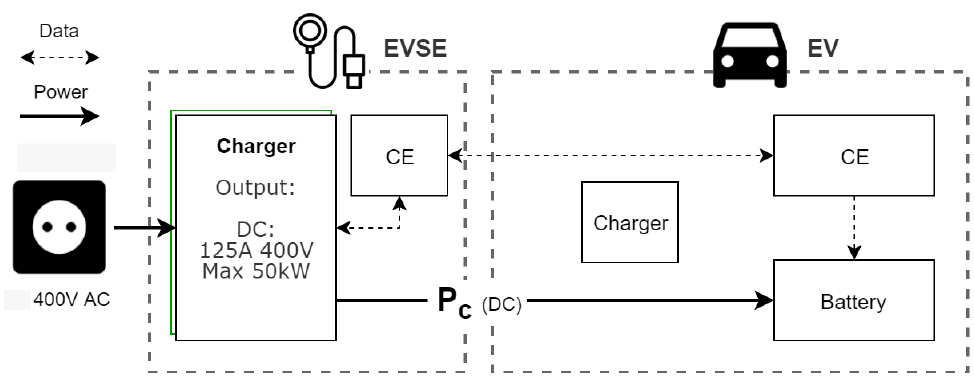
Figure 3. EV charging with a Mode 4 charging point. Energy is converted to DC before being sent to the EV, allowing for high charge speeds. CEs of both the EVSE and EV still communicate for security